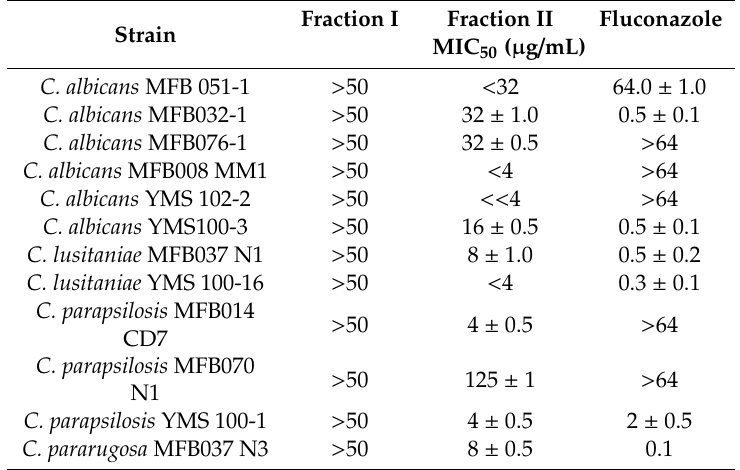
Table 3. Anti- Candida activity of fractions collected after chromatographic separation of H. mexicanum lipophilic